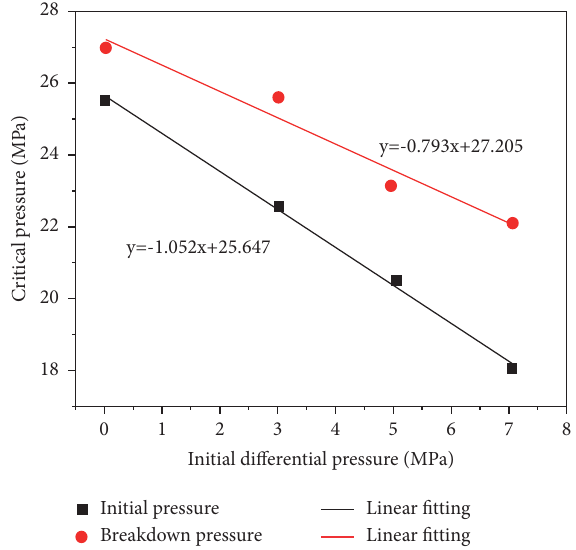
Figure 12: Relationship of critical pressure and differential pressure.